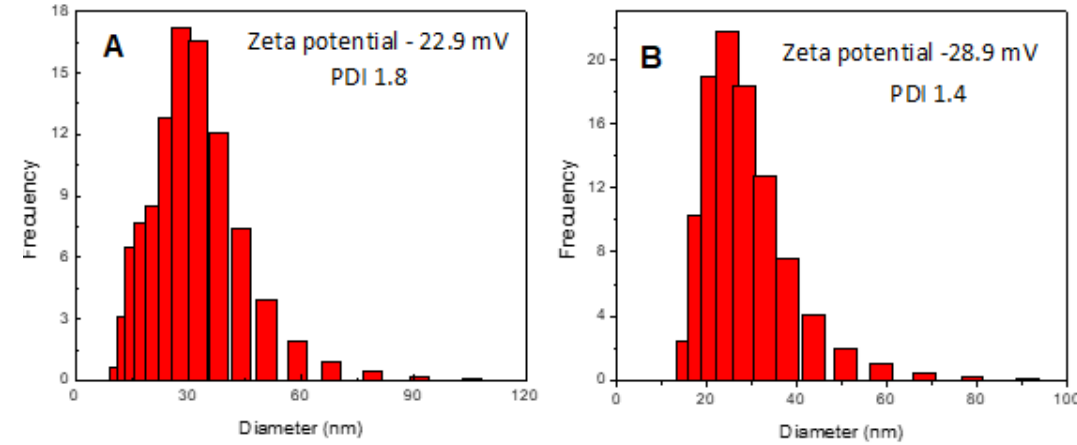
Figure 2. ( A ) Size distribution of SeNPs. ( B ) Size distribution of GA-COO-SeNPs.